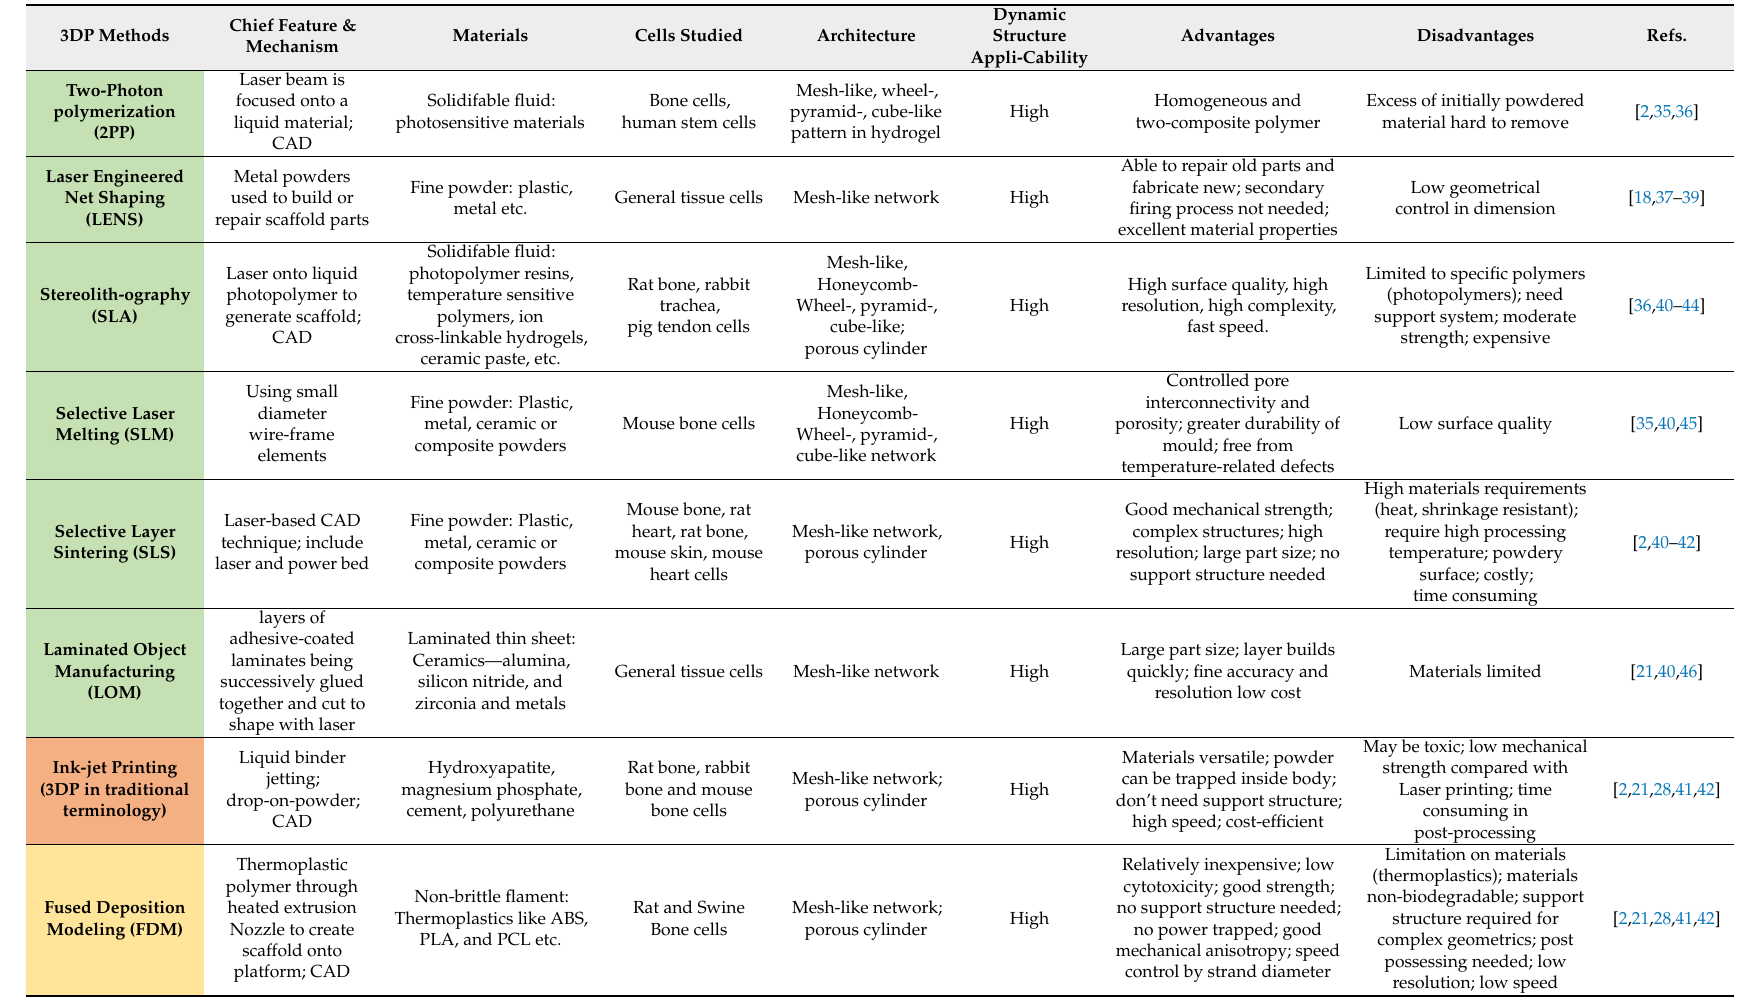
Table 1. Comparison table of various 3DP technologies for fabrication of three-dimensional (3D) cell